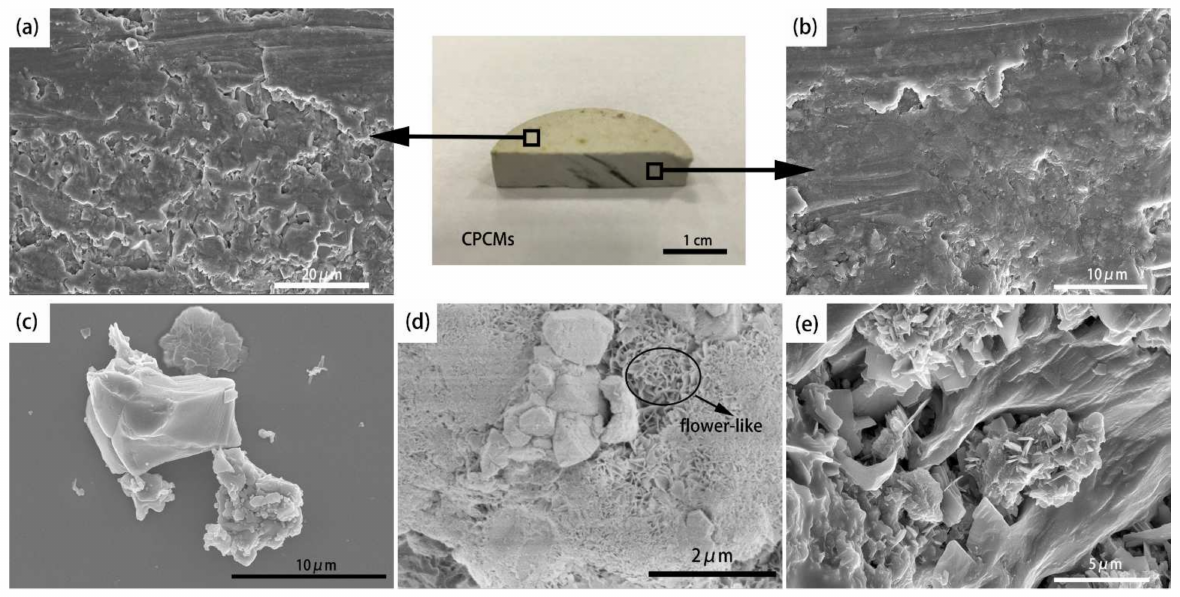
Figure 4. SEM images of 15CPCMs and components: ( a ) upper surface, ( b , e ) section of 15CPCMs, ( c ) AlN and ( d ) h-Al 2 O 3 .